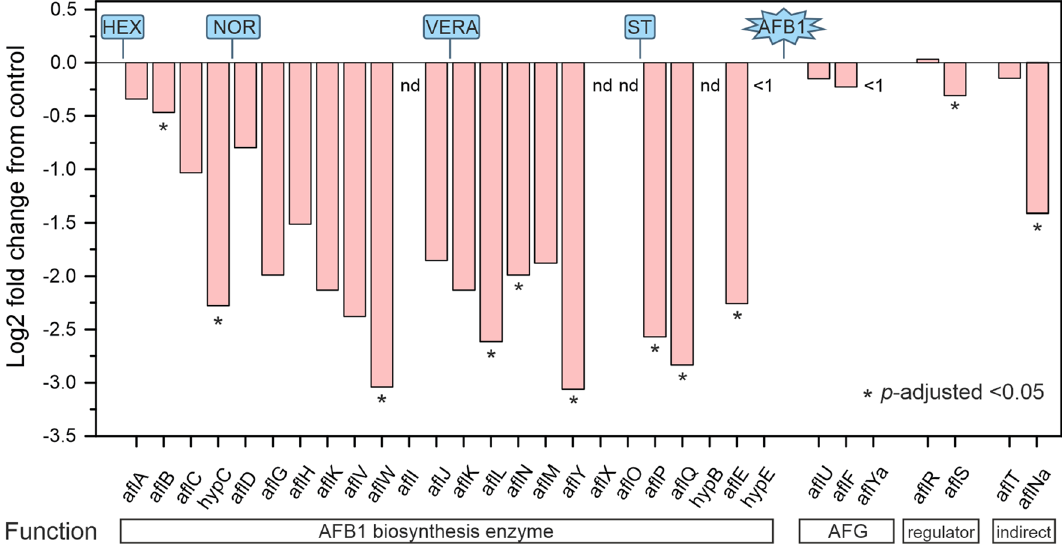
Figure 5. Effect of M20 extract treatment on AF cluster gene expression based on RNA-seq data. The names and reaction sequence locations of prominent chemical starter compounds (hexanoate, HEX) and intermediates, norsoloric acid (NOR), versicolorin A (VERA) and sterigmatocystin (ST), of the AFB1 synthesis pathway are shown. AFG indicates genes with a specific function in the synthesis of AF G-types. Genes absent in the reference genome annotation are indicated by nd. Genes with less than a threshold level of expression (FPKM < 1) are indicated by <